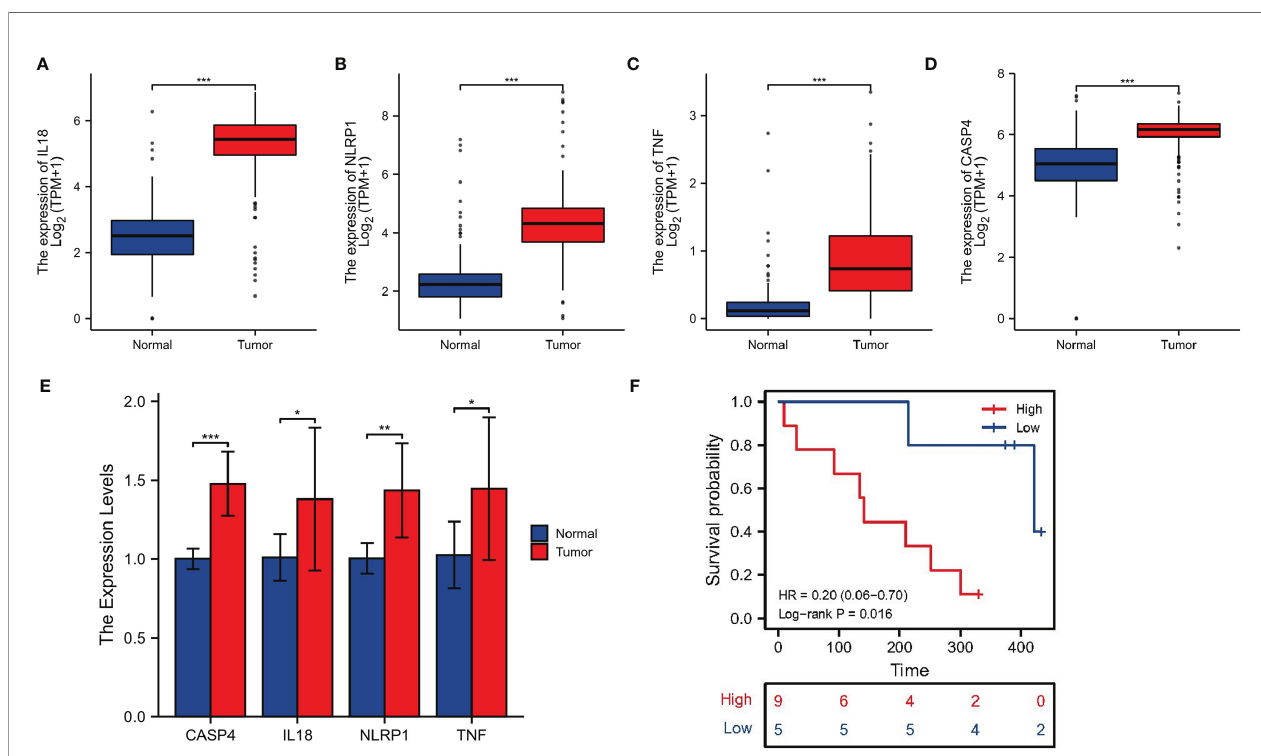
FIGURE 7 | Clinical sample validation. (A – D) The expression of four signature-associated genes between tumor tissues and normal tissues on basis of the GTEx database and TCGA database. (E) qRT-PCR of the expression of four signature-associated genes in clinical samples. (F) Survival analysis. *p < 0.05; **p < 0.01; ***P <